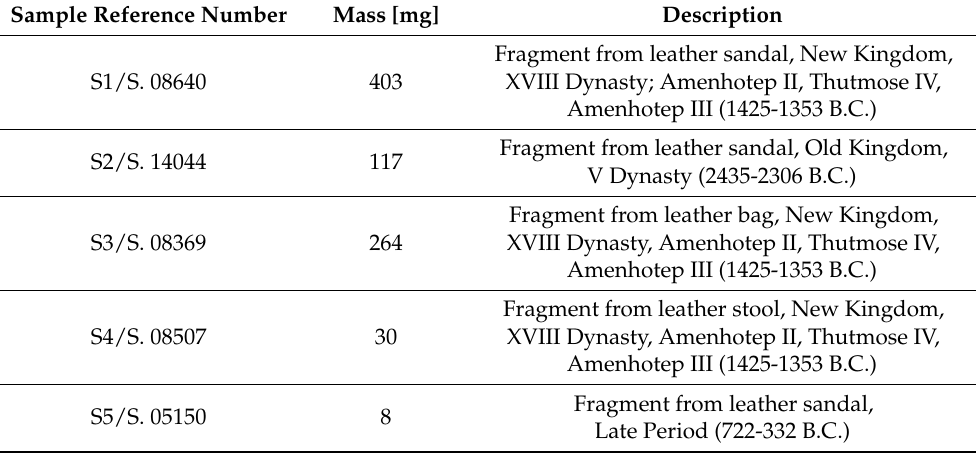
Table 1. Reference number, mass, and description of the samples from Museo Egizio (Turin, Italy) used in the present